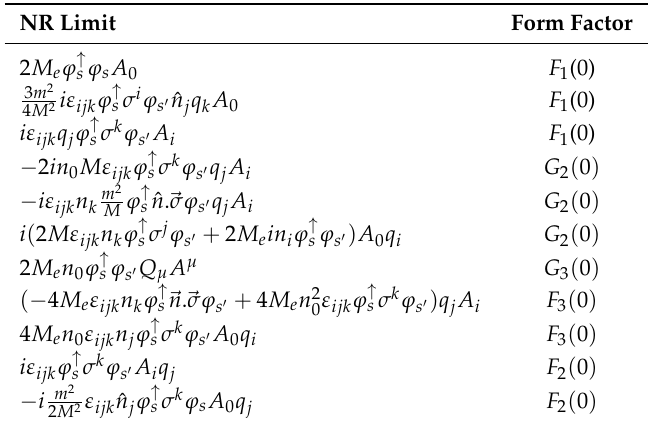
Table 1. In the right column, we list the form factor. In the left column, we have the non-relativistic (NR) limit of the matrix element accompanying the form factor in (26). All form factors are evaluated at q µ = 0. Here, A 0 is the electric potential and A i is the vector potential. ϕ s (cid:48) is a two- dimensional constant vector that corresponds to the NR limit of the Dirac